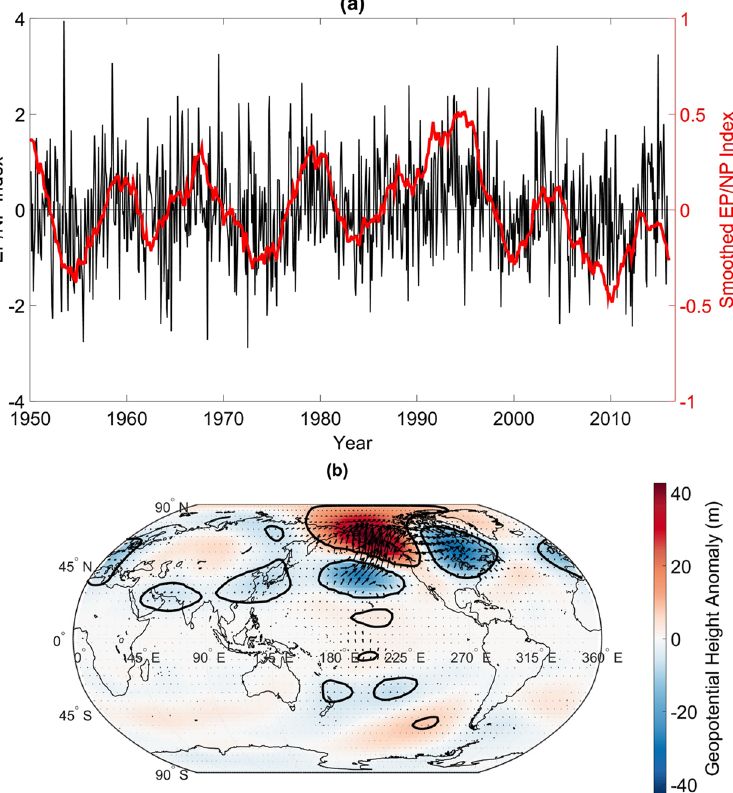
Figure 1. EP/NP Time series and EP/NP pattern. ( a ) The EP/NP index from 1950 to 2015 (black curve) together with the 5-year running mean. To reduce edge effects, the running mean was calculated by padding the left edge of the time series with the first value of the time series and padding the right end of the time series with the last value of the time series. Note that the raw and smoothed time series are plotted on different scales. ( b ) Composite of 500-hPa geopotential height anomalies for the positive EP/NP phase. Arrows indicate the wave activity flux ( m 2 s 2 ), which have been scaled relative to maximum wave activity flux vector length of 0.89 m 2 s 2 . The map was generated using MATLAB’s geoshow routine (MATLAB 2015a, http://www.mathworks.com/